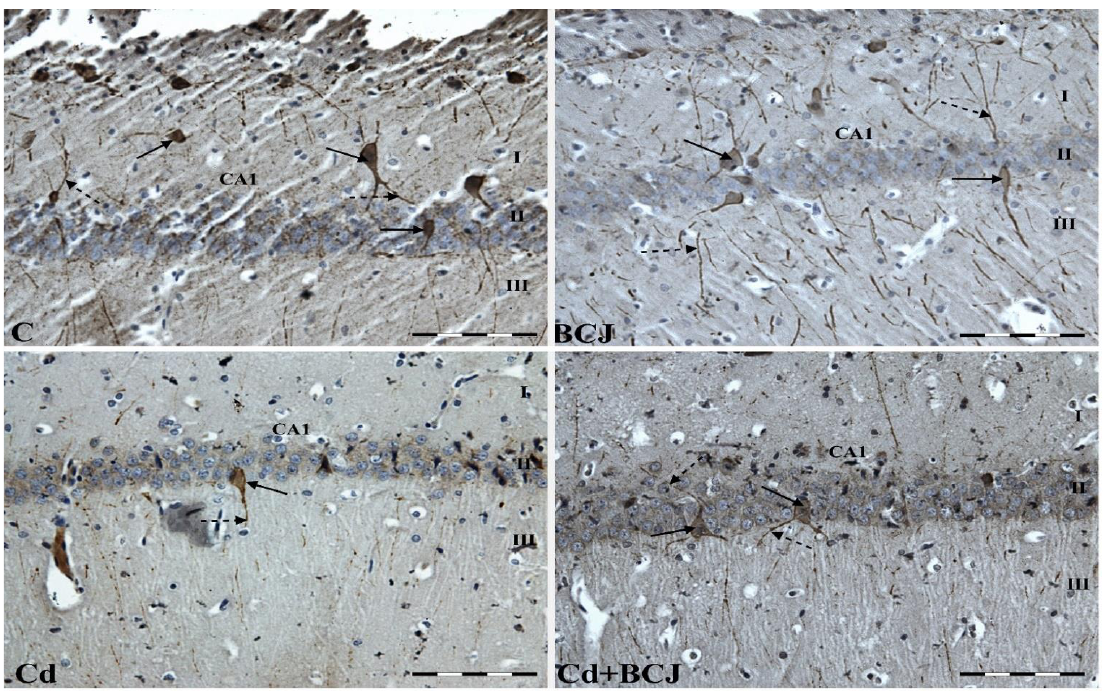
Figure 1. Cr-IR neurons and Cr-IR fibers in the hippocampal CA1 fields of experimental rats’ brains in the respective groups: C — the control group received 100 mL of tap water; Cd group — received Cd 2+ dissolved in 100 mL tap water/day (equivalent to 5 mg Cd 2+ /kg b.w.); BCJ group — received 100mL of juice per day; Cd+BCJ group — received juice with the addition of Cd 2+ ions (Cd 2+ dissolved in 100 mL juice/day (equivalent to 5 mg Cd 2+ /kg b.w.); I: the marginal layer, II: the pyramidal layer, III: the multiform layer; the arrows indicate Cr-IR neurons (solid one) and Cr-IR fibers (dotted one) of the hippocampus. Scale bars = 20 μm .